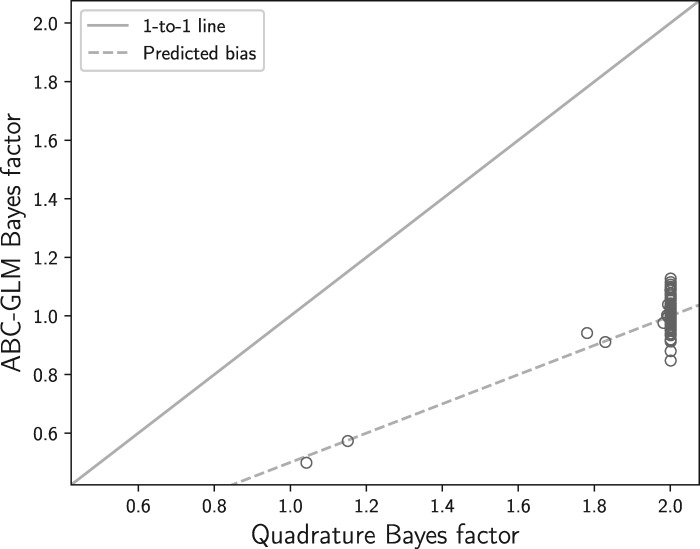
A comparison of the approximate-likelihood Bayesian computation general linear model (ABC-GLM) estimator of the marginal likelihood (Leuenberger and Wegmann 2010) to quadrature integration approximations (Xie et al. 2011) for 100 simulated data sets. We compared the ratio of the marginal likelihood (Bayes factor) comparing the correct branch-length model [branch length \documentclass[12pt]{minimal}
\usepackage{amsmath}
\usepackage{wasysym}
\usepackage{amsfonts}
\usepackage{amssymb}
\usepackage{amsbsy}
\usepackage{upgreek}
\usepackage{mathrsfs}
\setlength{\oddsidemargin}{-69pt}
\begin{document}
}{}$\sim$\end{document} uniform(0.0001, 0.1)] to a model with a broader prior on the branch length [branch length \documentclass[12pt]{minimal}
\usepackage{amsmath}
\usepackage{wasysym}
\usepackage{amsfonts}
\usepackage{amssymb}
\usepackage{amsbsy}
\usepackage{upgreek}
\usepackage{mathrsfs}
\setlength{\oddsidemargin}{-69pt}
\begin{document}
}{}$\sim$\end{document} uniform(0.0001, 0.2)]. The solid line represents perfect performance of the ABC-GLM estimator (i.e., matching the “true” value of the Bayes factor). The dashed line represents the expected Bayes factor when failing to penalize for the extra parameter space (branch length 0.1 to 0.2) with essentially zero likelihood. Quadrature integration with 1000 and 10,000 steps using the rectangular and trapezoidal rule produced identical values of log marginal likelihoods to at least five decimal places for all 100 simulated data sets.